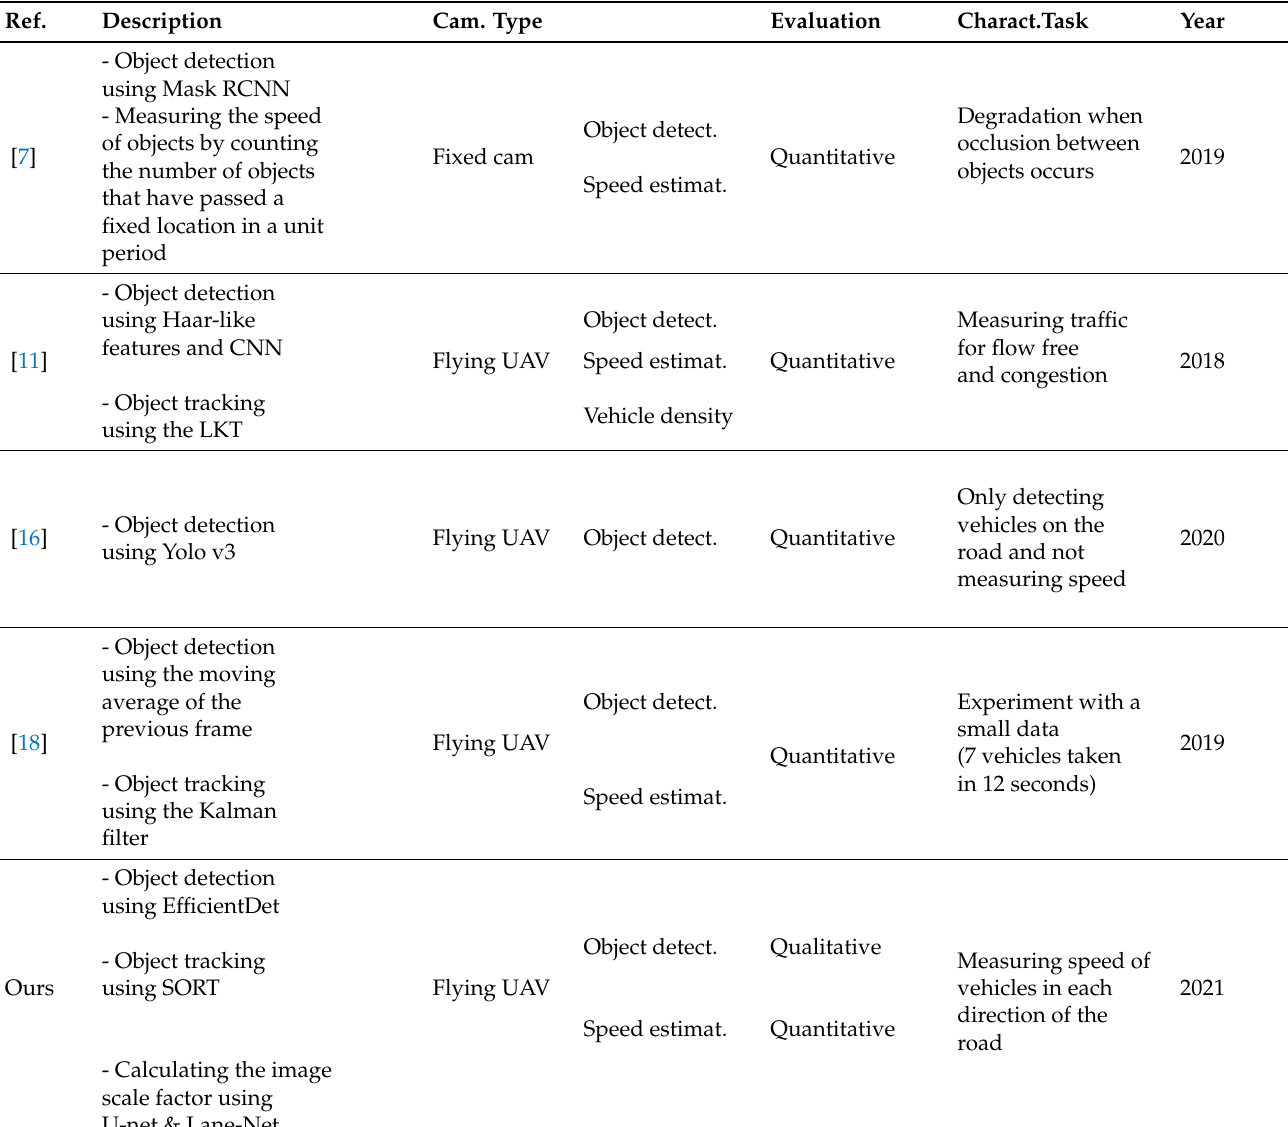
Table 4. Summary of the characteristics of several approaches for traffic analysis from road images.